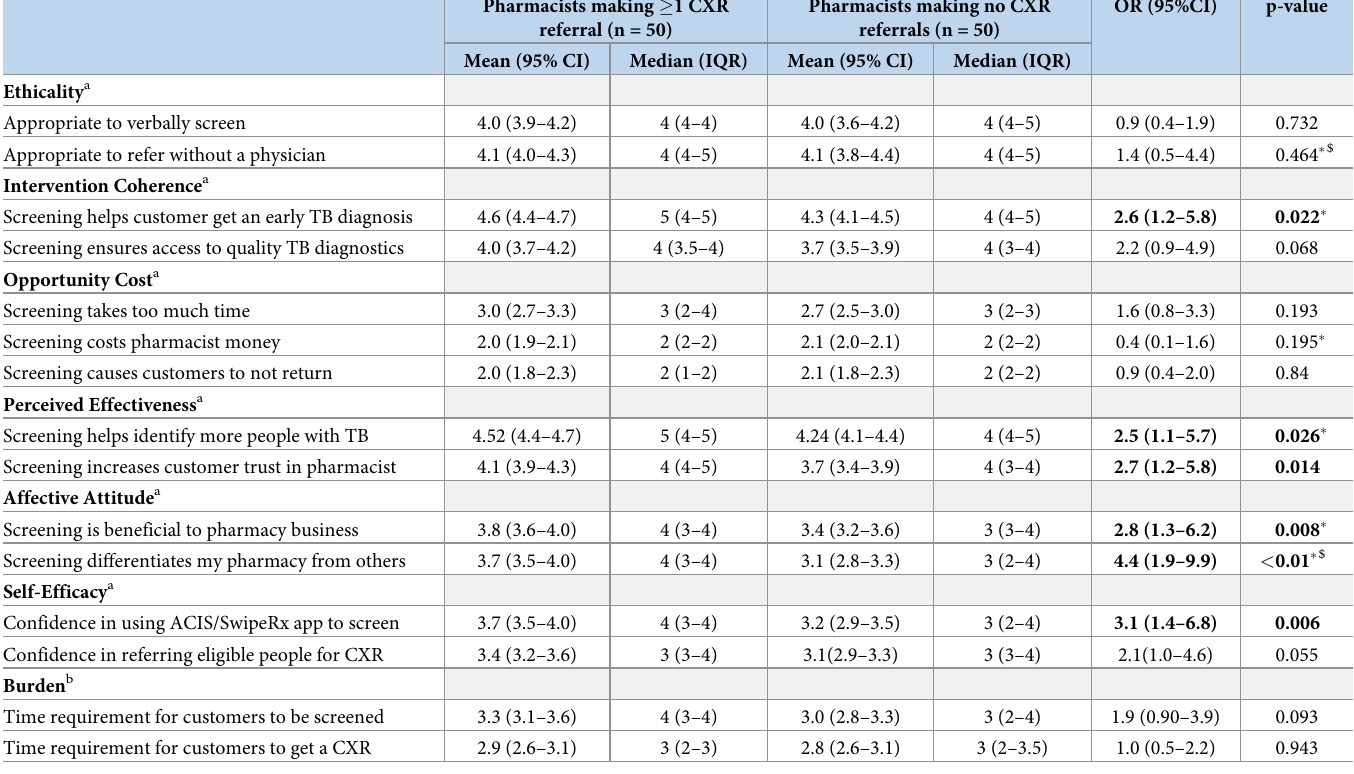
Table 4. Association of individual acceptability factors with making at least one CXR